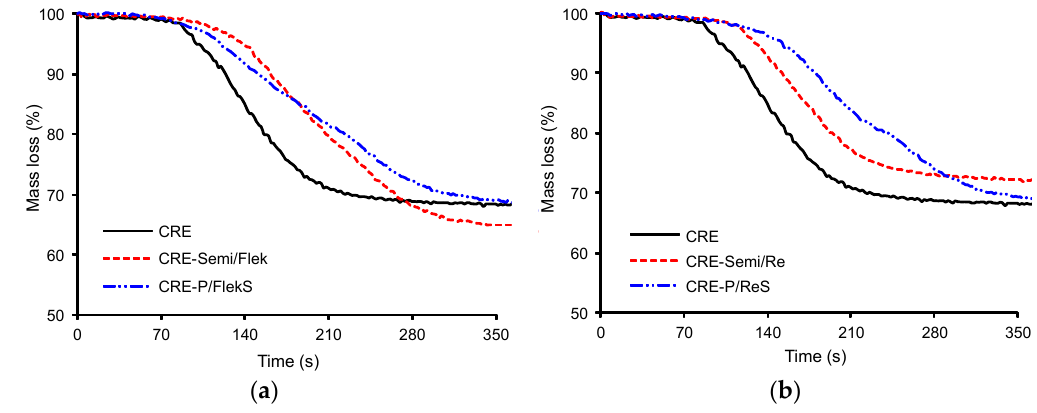
Figure 5. Mass loss versus time curves of the control and coated samples with ( a ) Flekashield and ( b ) Recoxit particles at 50 kW / m 2 heat flux.